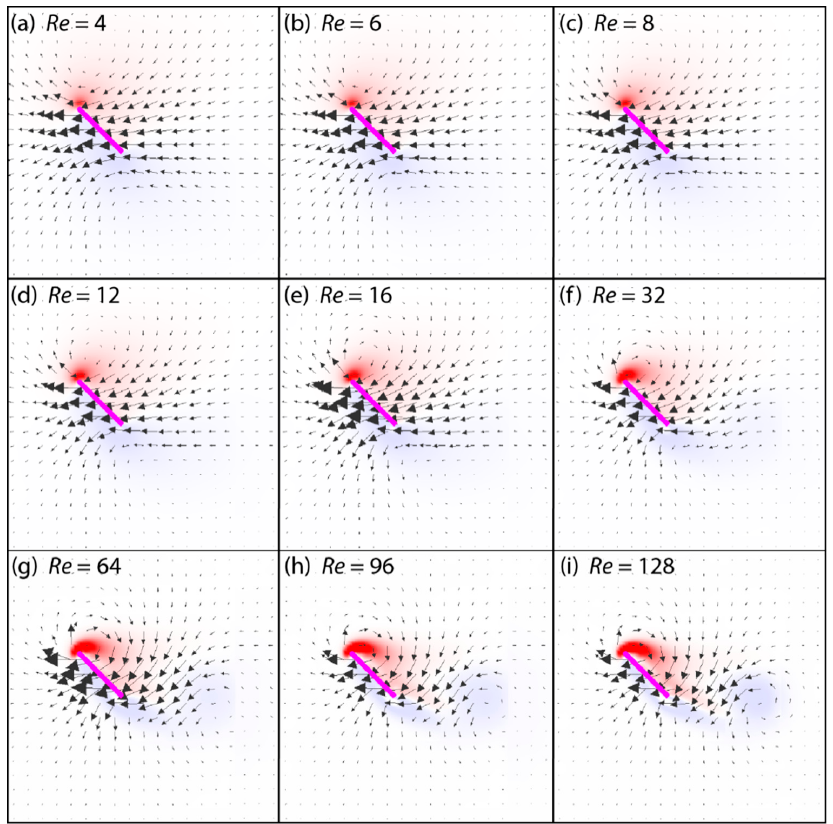
Figure 8. The vorticity plots for aoa = 45° at a range of Re . The cross-section shown is through the chord at the midpoint of the span, midway through the stroke. The vectors show the direction of flow and are scaled to the magnitude of the flow velocity. The color map shows the vorticity of the fluid (red = clockwise and blue = counterclockwise; min = − 30 and max = 30). Note that the wing is traveling to the left.